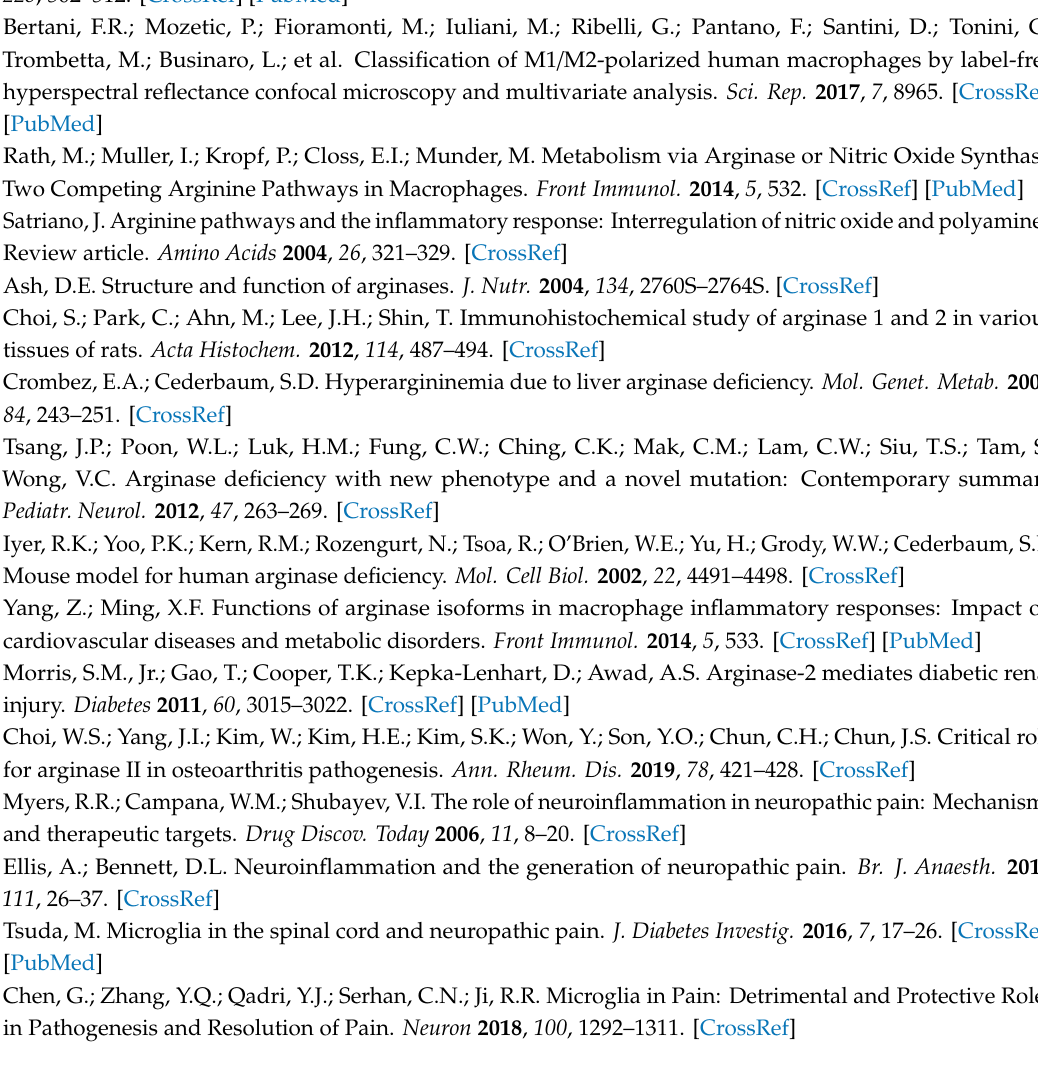
Figure S1: Print area; Figure S2: Single